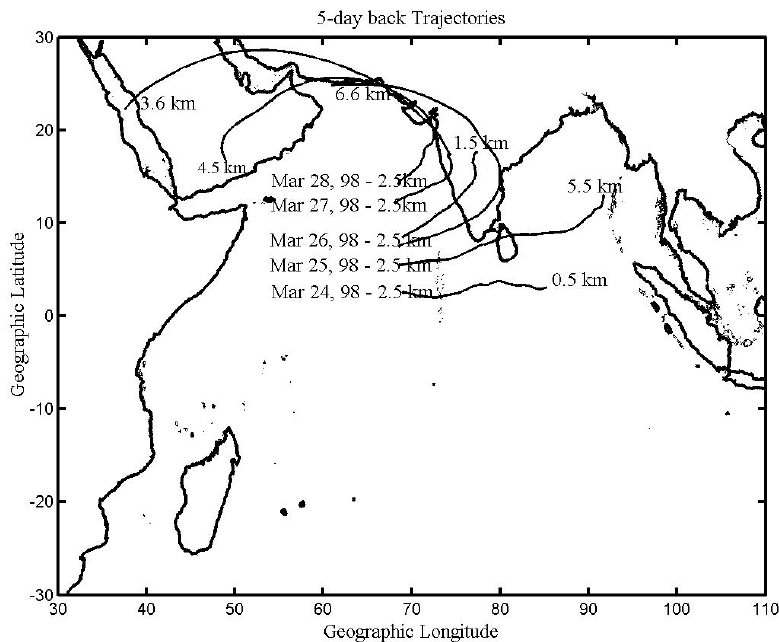
Fig. 11. Five-day back trajectory analysis for the thin layer cases which are shown in Fig. 10. The numbers that are shown at the end of the trajectories indicate the height from where the trajectories are originated. (Courtesy of NOAA Air Resource Laboratory;